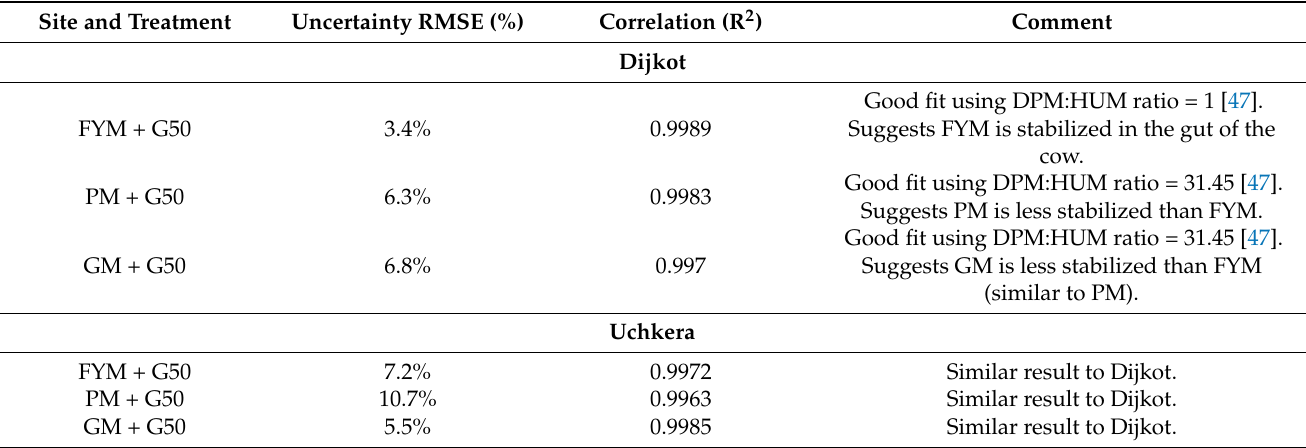
Table 6. Evaluation of organic manure parameters in pot experiments using soils from Dijkot and Uchkera. Note: FYM = farmyard manure, PM = poultry manure, GM = green manure (all applied